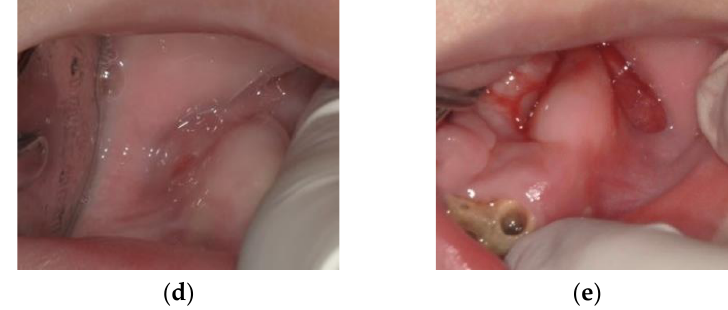
Figure 7. Extra- and intraoral photographs acquired at the age of 6 years and 5 months: ( a ) mandibular, ( b ) left side of face, ( c ) mandibular, ( d ) mandibular right region, and ( e ) mandibular left region.